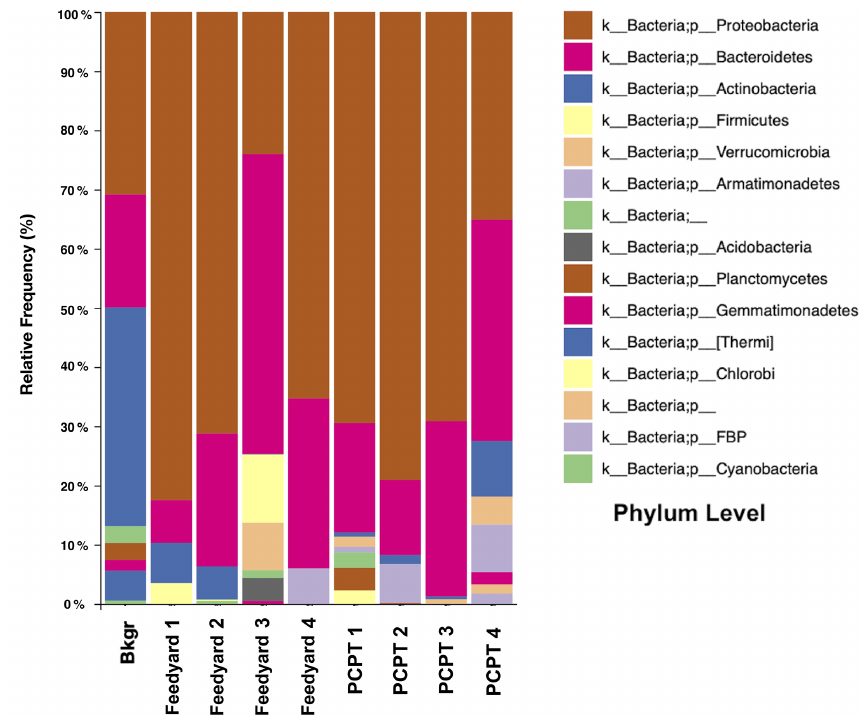
Figure 6. Bacterial community analysis of precipitation and cattle feedyard dust samples showing Relative Frequency (%) or abundance of Bacterial taxonomy. “Bkgr” represents the 24h dry deposition blank sample (sample no. 34). Our cattle feedyard samples are collected locally on 28 March 2019 (1), 22 July 2018 (2), 23 July 2018 (3), and 24 July 2018 (4) – see Hiranuma et al. (2020). PCPT 1–4 corresponds to our sample nos. 1, 2, 50, and 7,